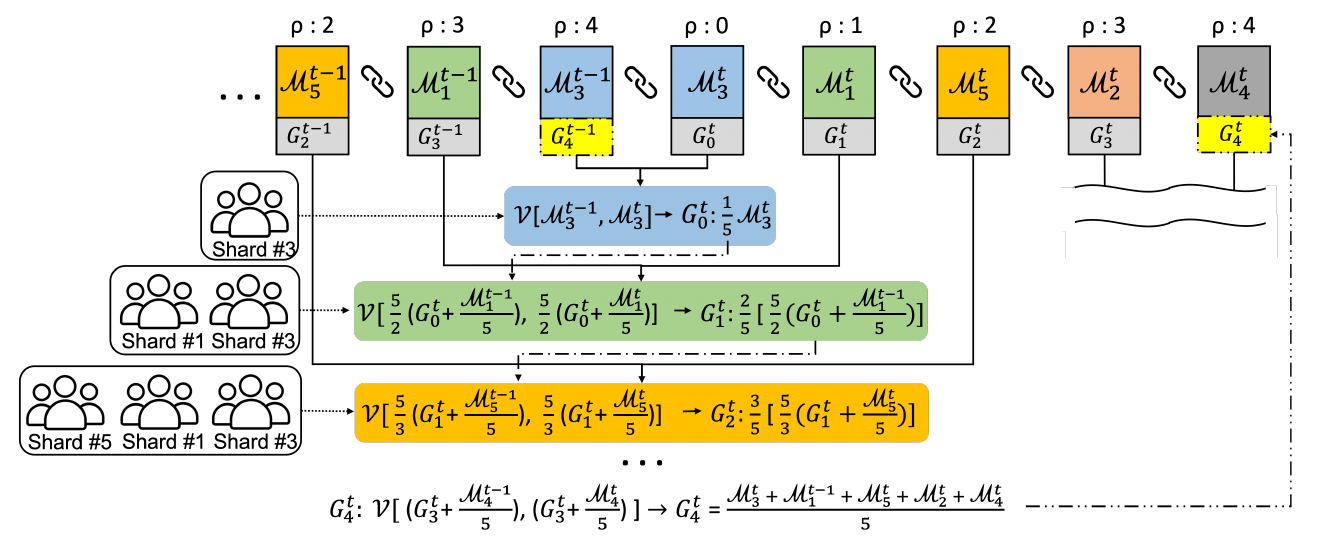
Figure 3. Example of global model